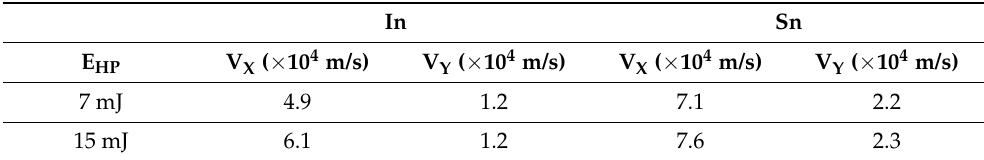
Table 1. Calculated velocities of plasmas along the longitudinal (V X ) and transverse (V Y ) axes using the linear fits of the graphs shown in Figure